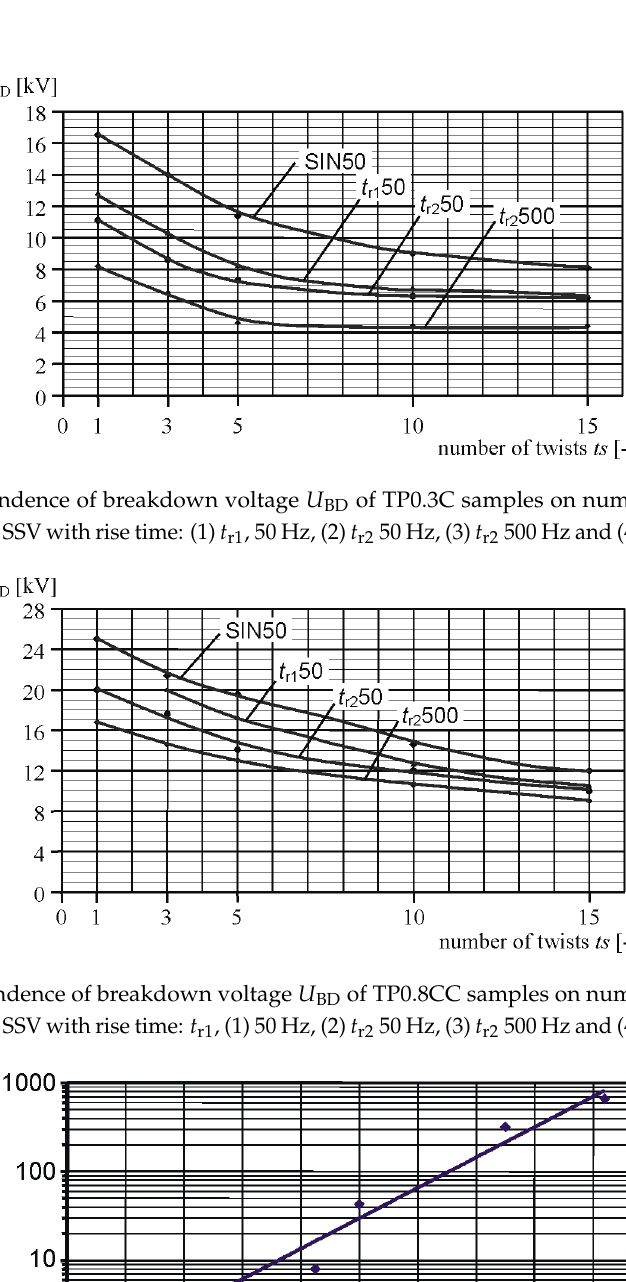
Figure 9. Influence of magnet wire diameter d w on time ‐ to ‐ breakdown t b for the same testing voltage.